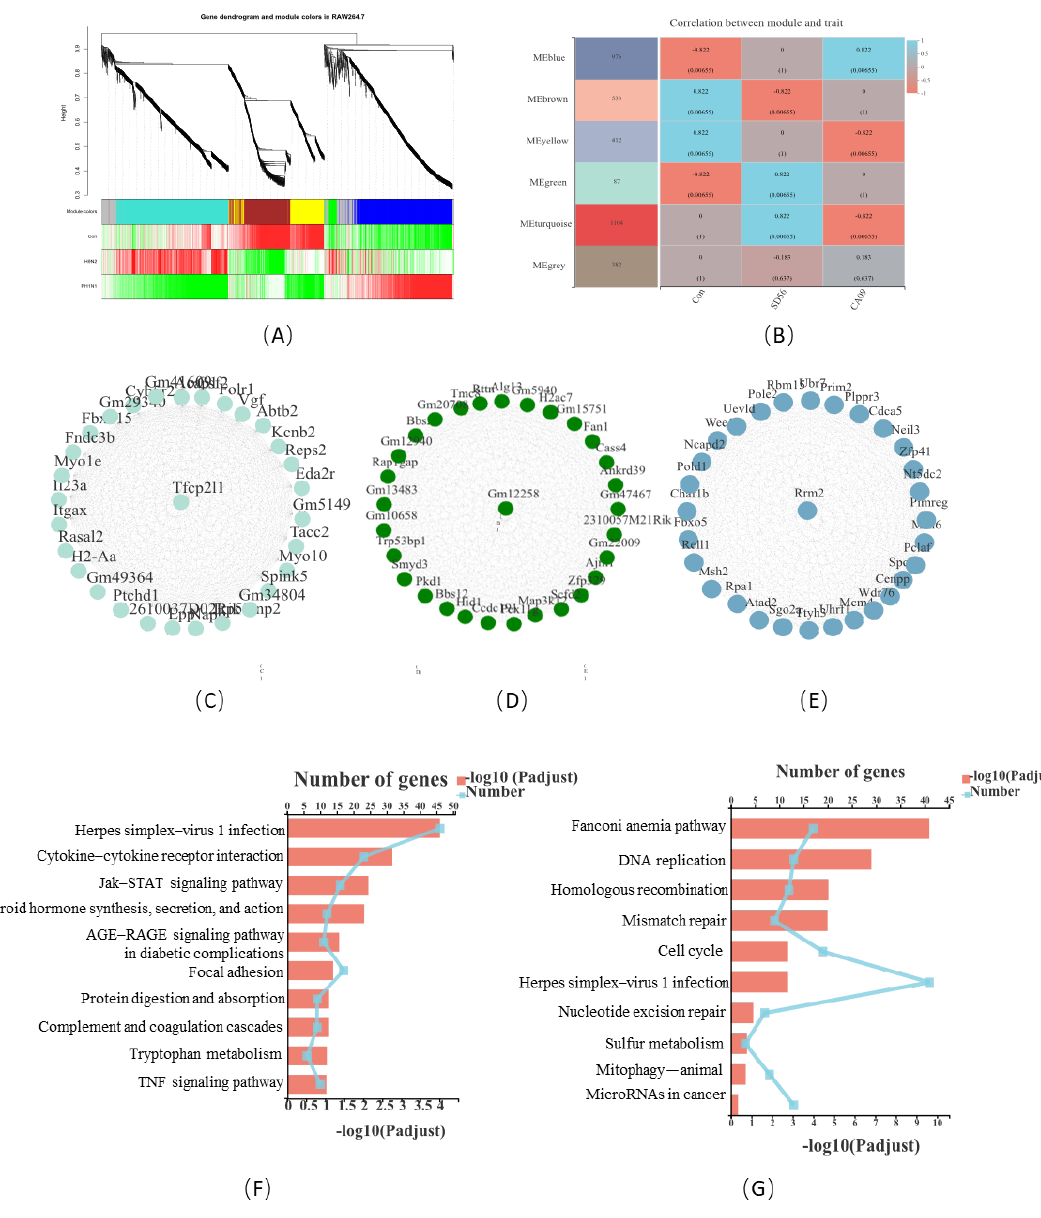
Figure 7. WGCNA of the expression data. ( A ) Gene co-expression modules. Genes that could not be clustered into one of these modules were assigned to the grey module. Different colors represent different modules. Each row represents a phenotype, and each column represents a gene in the module. ( B ) Module–trait relationship. The top value in each square shows the correlation between the module eigengene and the outcome. The bottom value is the p -value of each correlation. ( C – E ) Visualization of the three modules that were highly correlated with infections with a p -value less than 0.05 using Cytoscape. ( F , G ) KEGG enrichment of the different